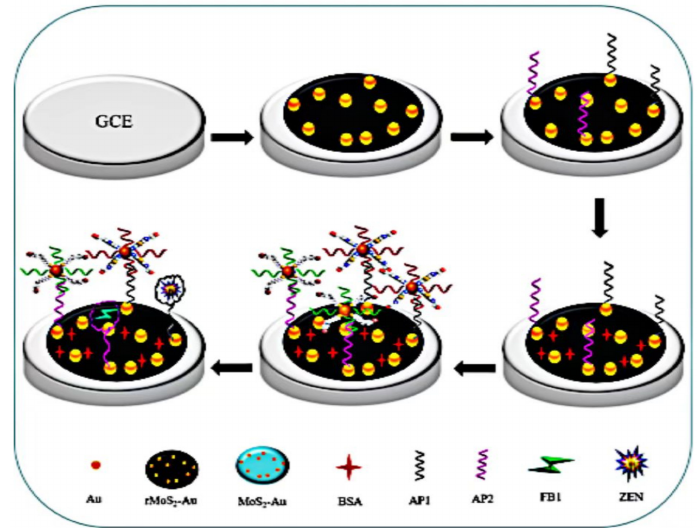
Figure 6. Schematic illustration of the preparation of a dual-target electrochemical aptasensor for multiplex detection of mycotoxins. Reproduced with permission from Han et al. [112], Biosens. Bioelectron.; published by 2019 Elsevier B.V. Table 6. Representative studies of electrochemical biosensor for detecting mycotoxins from food sample by metal